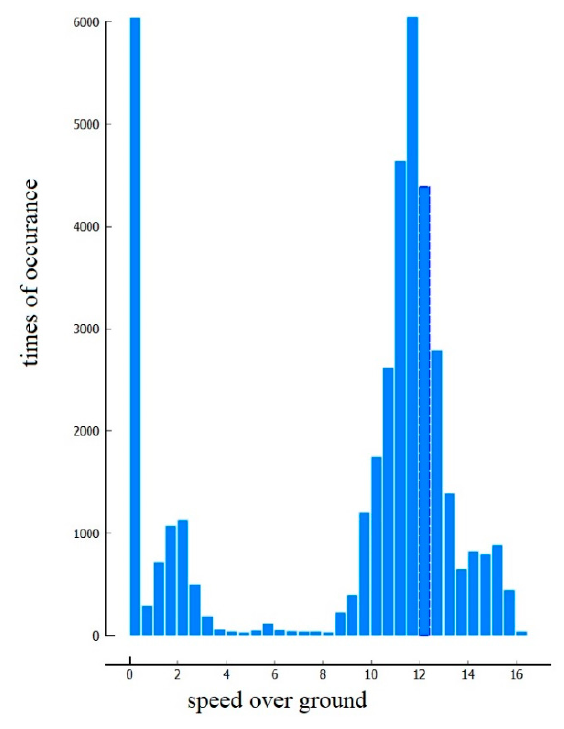
Figure 6. The ship’s cruising speed distribution.